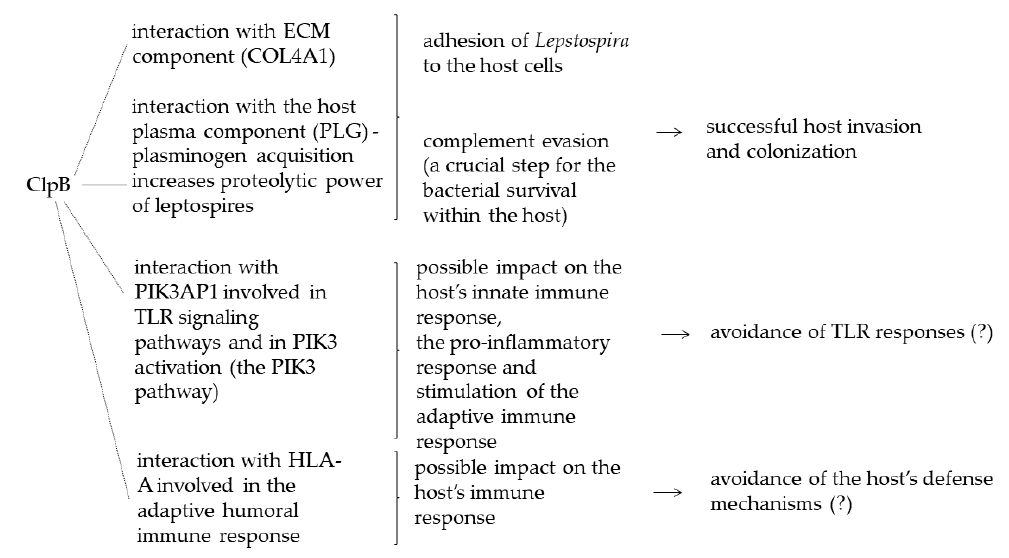
Figure 3. The most important potential ClpB–human proteins interactions and their possible role during leptospiral infections